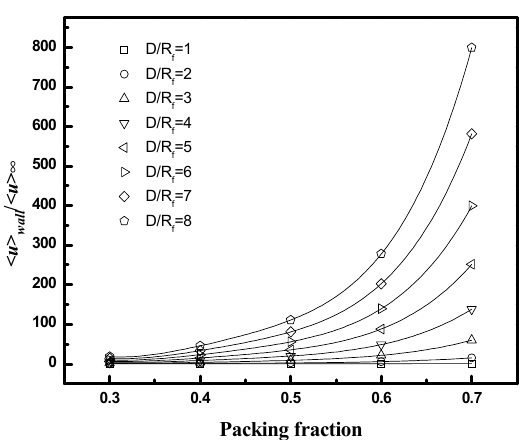
Figure 14. <u> wall /<u> ∞ as a function of packing fraction and D/R f for equilateral triangular configuration.